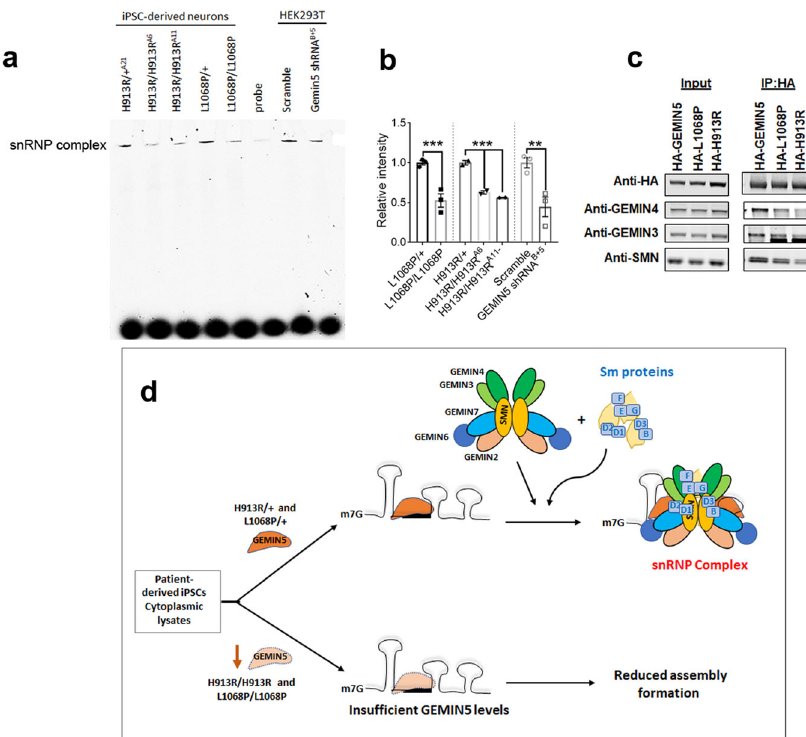
Fig. 5 Biallelic variants in GEMIN5 disrupts SMN assembly formation in vitro. a Representative gel image showing the in vitro snRNP assembly formation by using 3 ′ Cy3-biotin-labeled U1 snRNA and the cytoplasmic extract from heterozygous and homozygous L1068P and H913R neurons as well as from the HEK293T cells transfected with GEMIN5 shRNA. b Quantitative analysis of the in vitro SMN complex formation as given in ( a ) (one-way ANOVA- Bonferroni test, n = 3) . c Immunoprecipitation blot showing the reduced interaction of HA-tagged Leu1068Pro and His913Arg variants with GEMIN4, GEMIN3, and SMN as compared to HA-GEMIN5 WT protein in HEK cells. d Diagrammatic representation showing the possible mode of disruption in snRNP complex formation due to loss of GEMIN5 in L1068P and H913R variants. P -values ***<0.01, **<0.05. Source data are provided as a Source Data fi